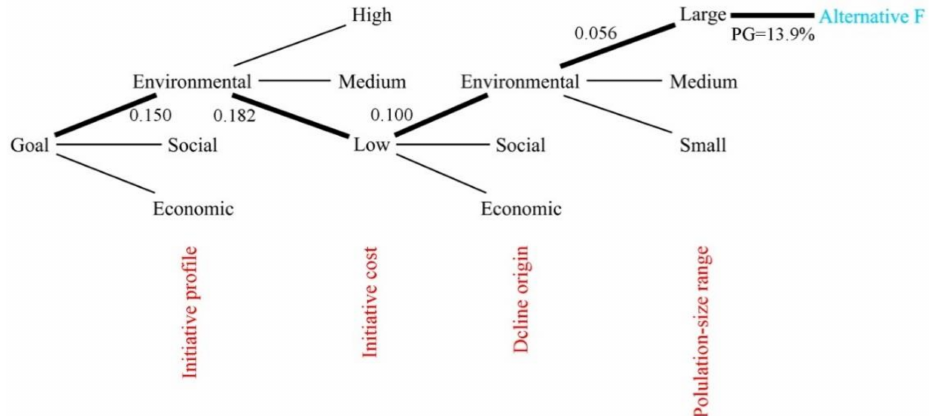
Figure 3. The decision tree structure constructed for the decision process. Notes: The criteria used in the sequential decision tree were sorted according to priorities obtained by the AHP structure. Local priorities are shown along the branches in each step. Global priority for alternative F (the one that best suits the case study) is given as a percentage. The criteria are shown in red. Due to spatial limitations only one branch of each criterion was shown. Source: Prepared by the